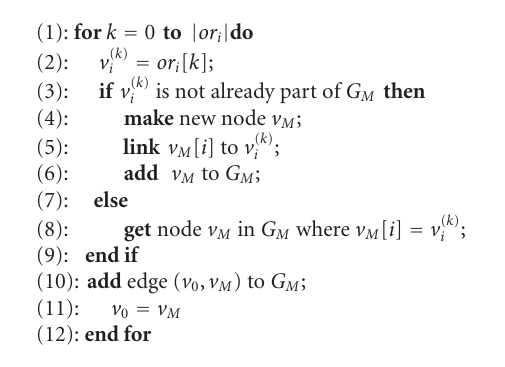
Algorithm 3: Adds an or-path or i to the merged graph G M . The or-path is part of the path p i . The last vertex of the path p i added to v G M is denoted by 0 . If no such vertex is given, as default, that is, the NOP node of G M .